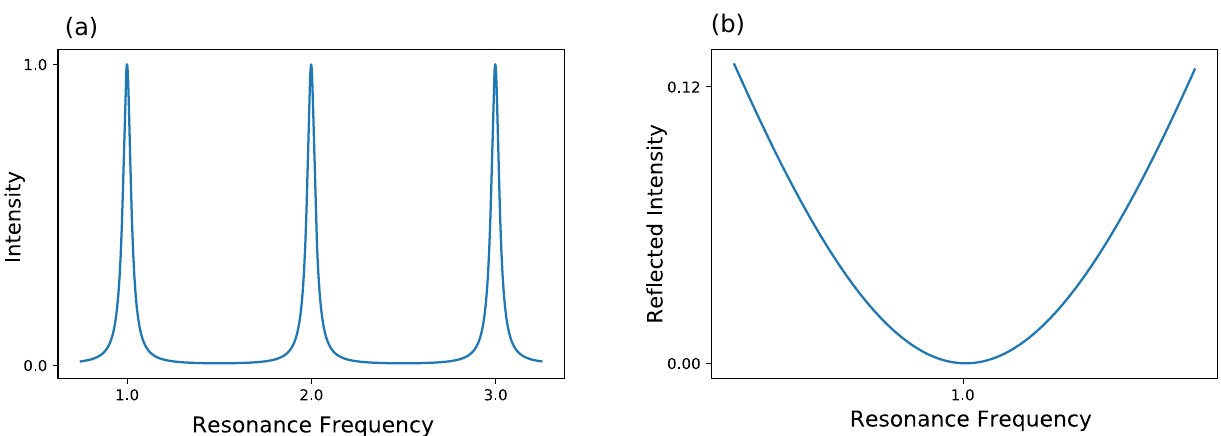
Figure 4. Behavior of a lossy Fabry-Perot resonator. ( a ) The intensity inside the resonator is shown. The intensity shows maxima at the cavity’s resonance frequencies and decreases away from these resonances due to destructive interference. ( b ) The reflected intensity is shown. At resonance frequency, the reflected intensity is dropping to